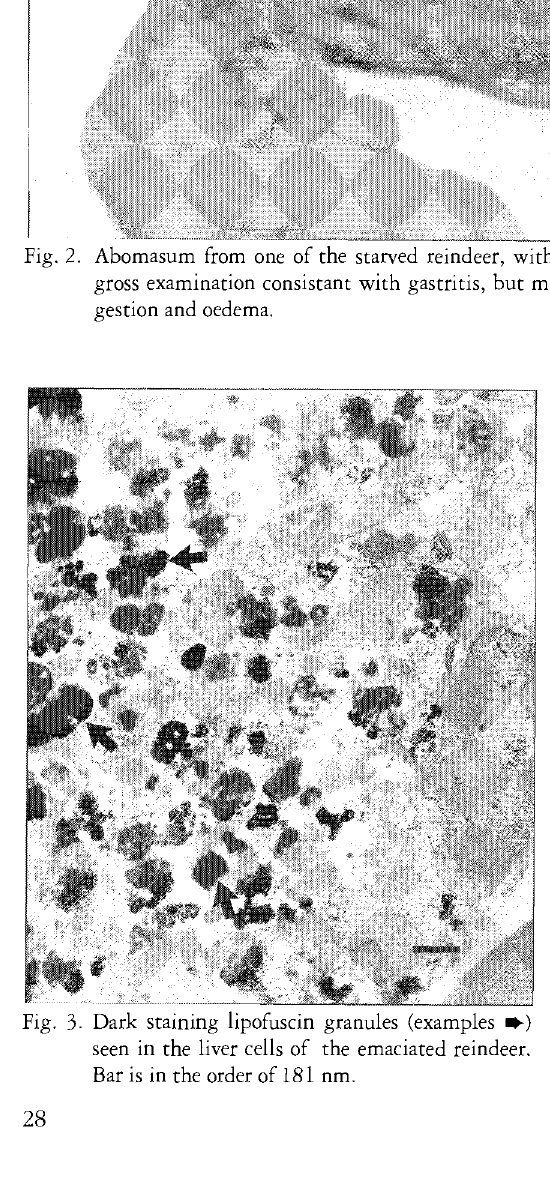
Fig. 3- Dark staining lipofuscin granules (examples seen in the liver cells of the emaciated reindeer. Bar is in the order of 181